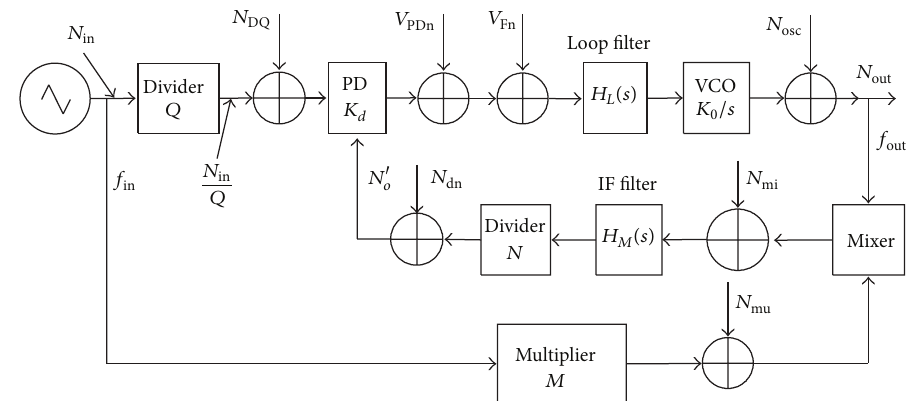
Figure 2: Model of a general PLL with additive